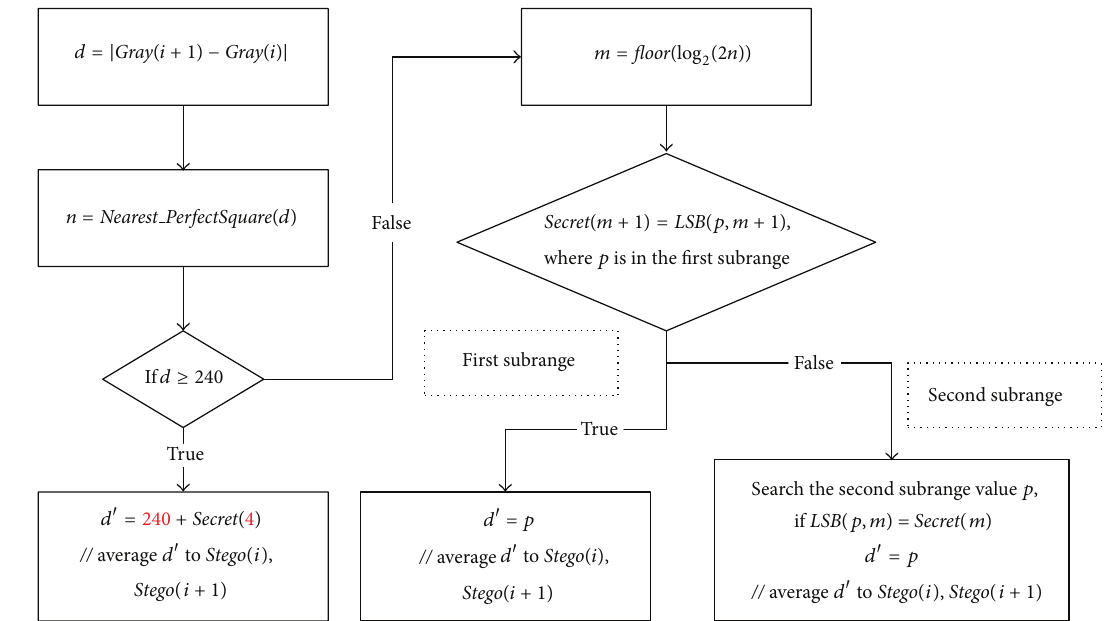
Figure 1: The embedding procedure.